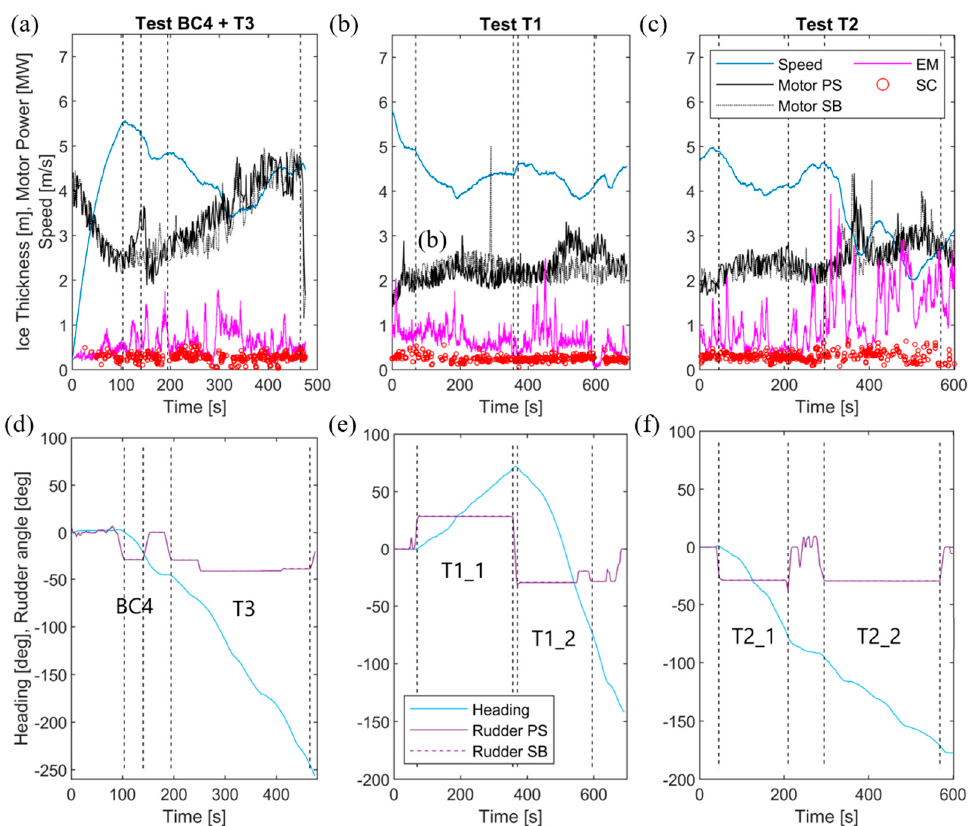
Figure A8. Applied motor power, measured ice thickness with the electromagnetic device (EM) and stereo camera system (SC), and obtained speed during tests ( a ) BC4 and T3, ( b ) T1_1 and T1_2, and ( c ) T2_1 and T2_2. Applied rudder angles with obtained heading during tests ( d ) BC4 and T3, ( e ) T1_1 and T1_2, and ( f ) T2_1 and T2_2.